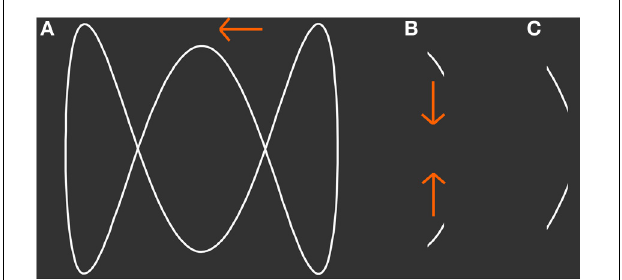
FIGURE 1 | Presented stimulus. (A) The shape of a 3-loop-figure that was simulated to move horizontally back and forth behind a narrow aperture. (B,C) Show snapshots of the figure that can be seen through the simulated aperture at two different points in time. Although only line segments are visible at each point in time the subject is able to perceive the figure as a whole. At a specific width of the aperture the participant’s conscious perception switches spontaneously between vertically jumping line segments and the horizontally moving figure. From (B) to (C) the figure moves to the